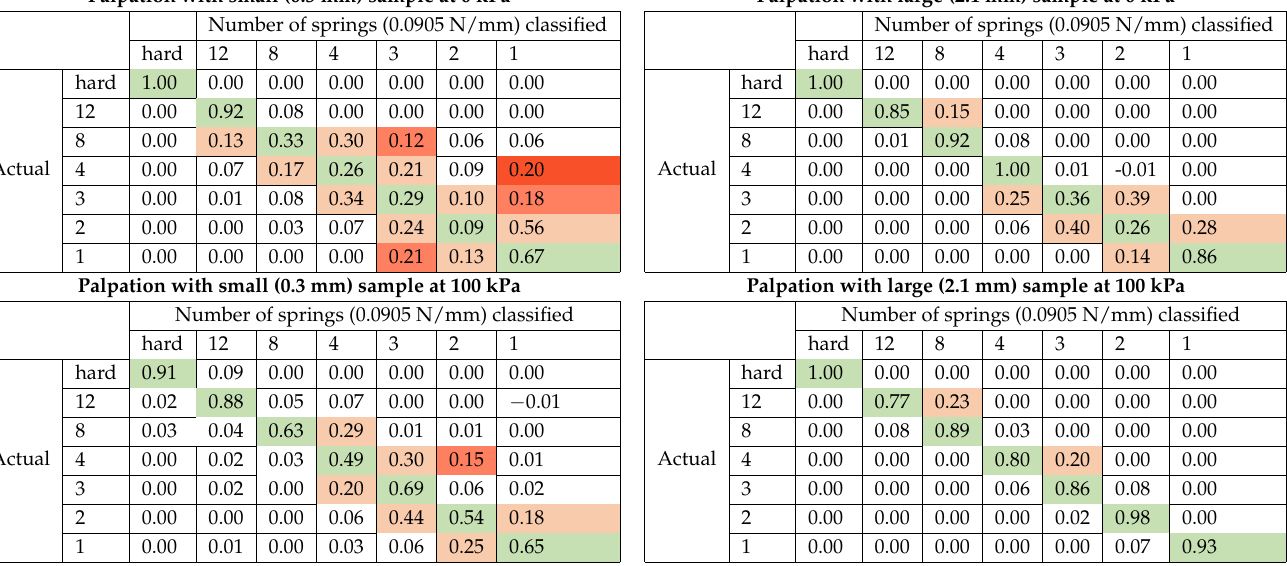
Table 1. Confusion Matrices for low and high pressure states of a 2.5 mm membrane ESPRESS.0 classifying the stiffness of a springboard based on the signal from small or large data samples. Green indicates correct classifications, while significantly populated ( ≥ 0.1) misclassifications are highlighted in a shade of red, the intensity of which is relative to the cell’s distance from the